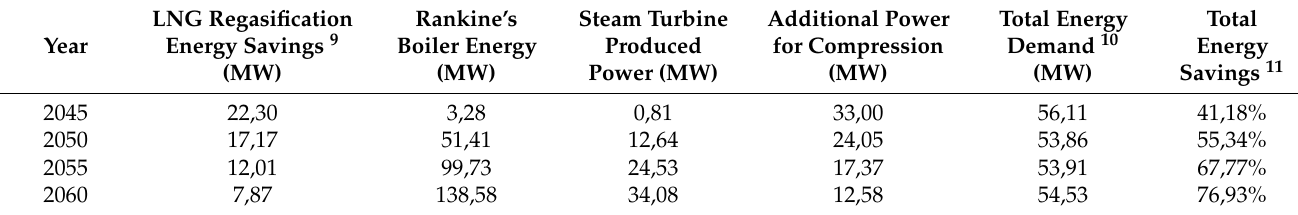
Table 14. Energy integration process results.